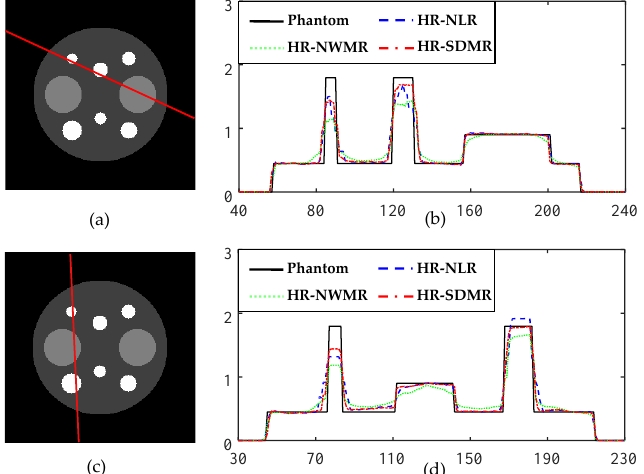
Figure 3. Profile plots for LR anecdotal reconstructions: ( a ) LR phantom with a profile line shown; ( b ) profile plots along the line shown in ( a ) for LR reconstruction methods (LNQR, LQR, NWMR and SDMR); ( c ) LR phantom with a profile line shown; ( d ) profile plots along the line shown in ( c ) for LR reconstruction methods (LNQR, LQR, NWMR and SDMR).